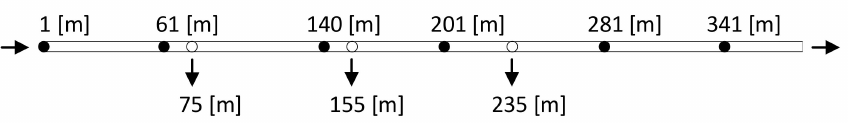
Figure 3. Pressure transmitters and leak point